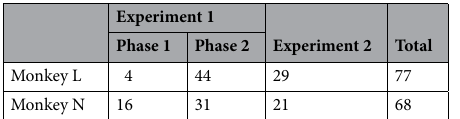
Table 1. Number of sessions used for the analysis for each